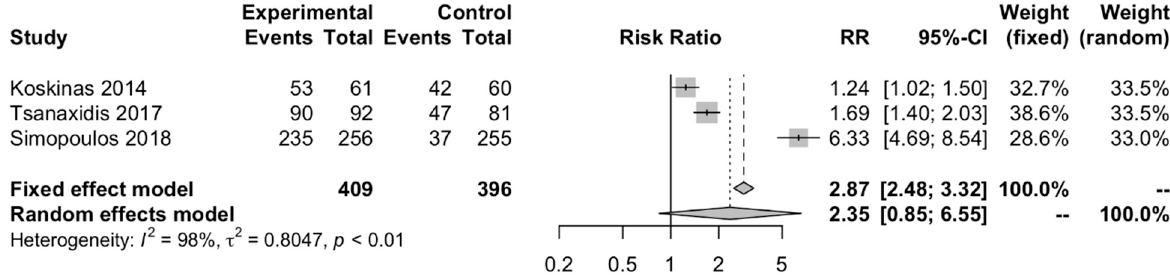
Figure 3. The forest plot meta-analysis showing the sinus rhythm restoration rate of ranolazine plus amiodarone group and amiodarone alone group.